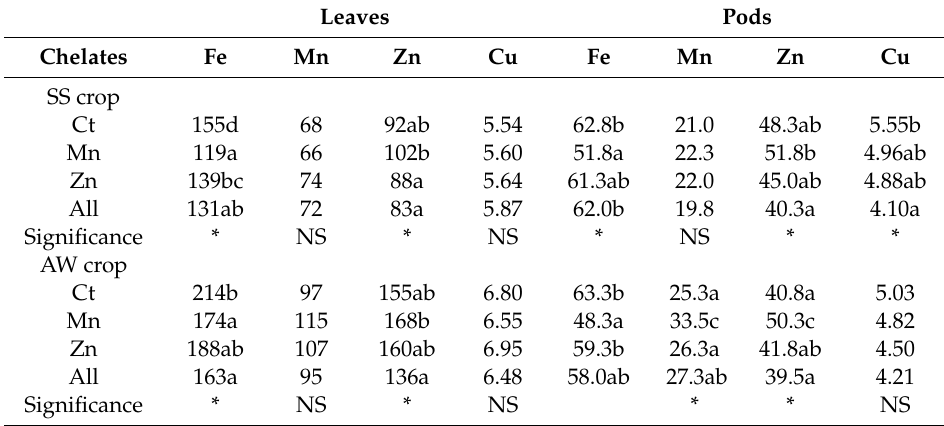
Table 3. Micronutrient concentrations as ppm ( µ g g − 1 DW) in leaves and fresh pods of NFT-grown common bean plants, 60 days after treatment initiation submitted to the chelate forms of Mn and Zn in the nutrient solution (NS) in two cropping seasons (spring-summer, SS crop; autumn-winter, AW crop). The treatments (NS) were: «Ct», NS with inorganic Mn and Zn; «Mn», NS with chelated Mn; «Zn», NS with chelated Zn; «All», NS with chelated Mn and Zn. Leaves Pods